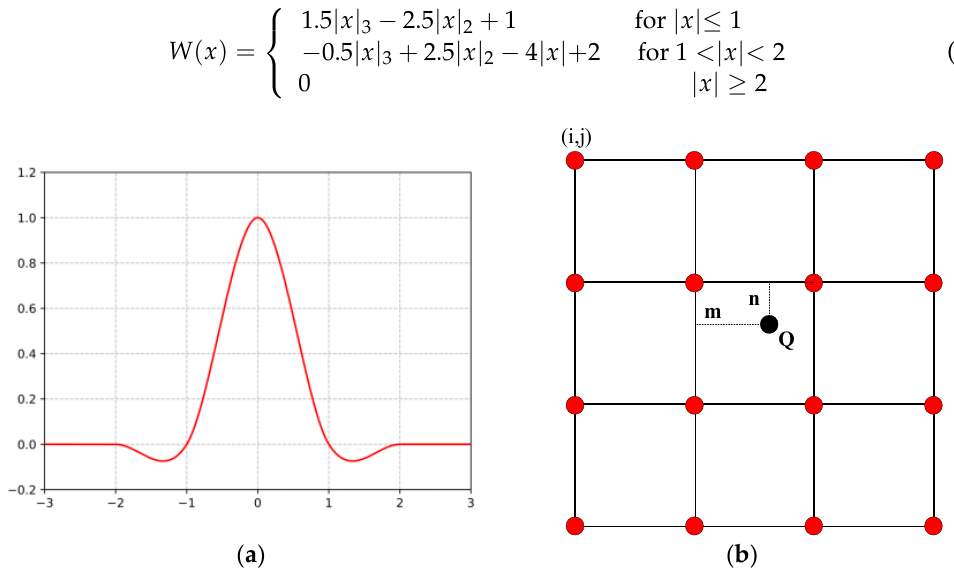
diagram of the bicubic algorithm.